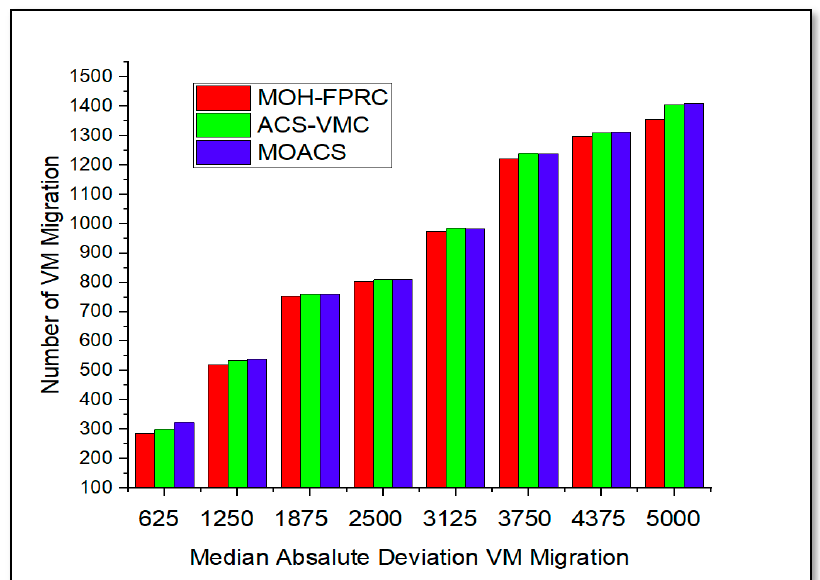
Figure 9. Comparison of algorithms using MAD migration strategy.